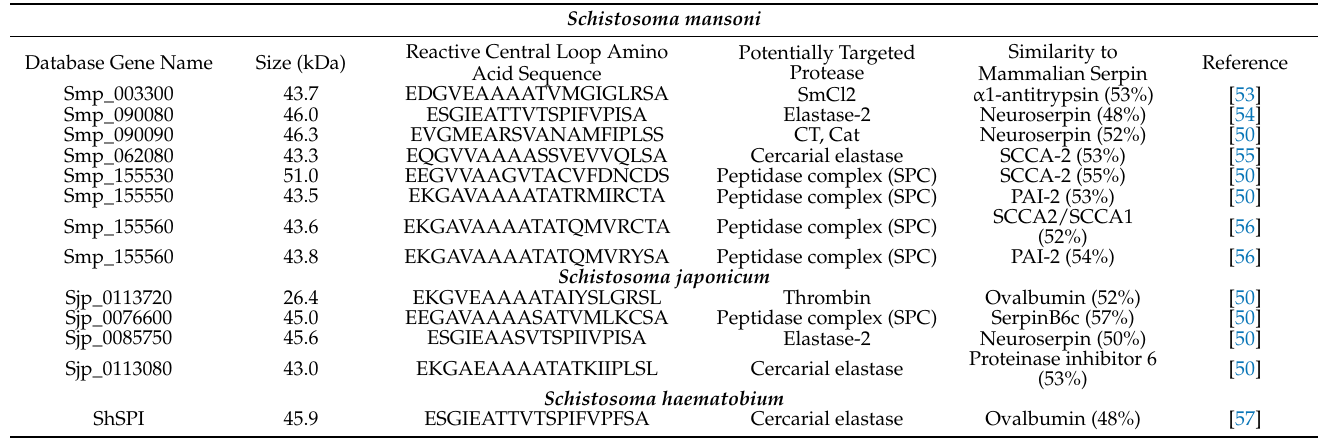
Table 1. Uncharacterized Schistosome